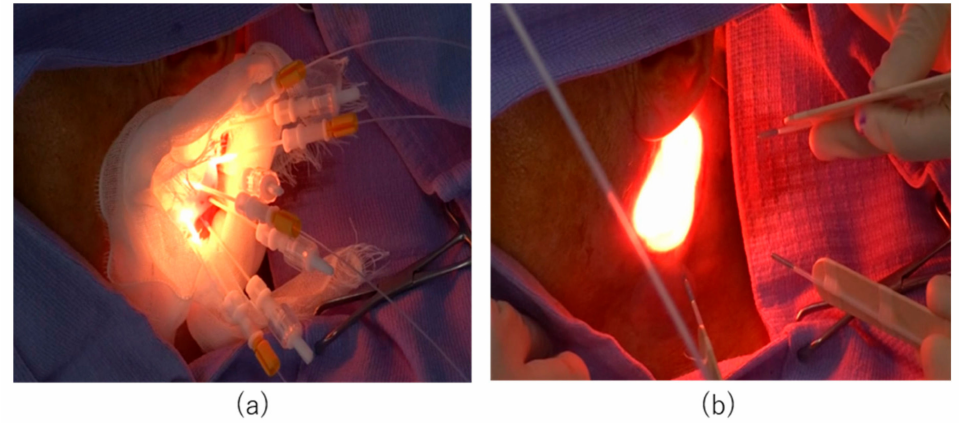
Figure 1. Laser illuminating devices. ( a ) Near-infrared laser illumination using cylindrical diffusers for a deep or thick lesion. ( b ) Near-infrared laser illumination using frontal diffusers for a superficial